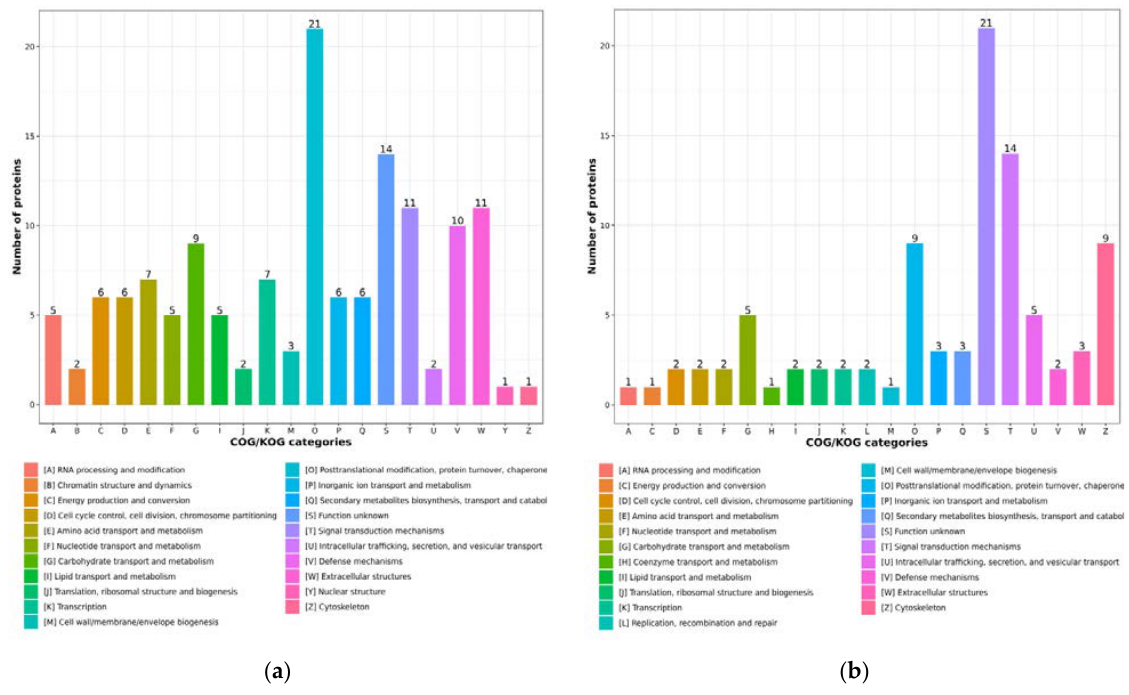
Figure 5. The COG/KOG categories of the DEPs: ( a ) the COG/KOG categories of the up-regulated proteins; ( b ) the COG/KOG categories of the down-regulated proteins.